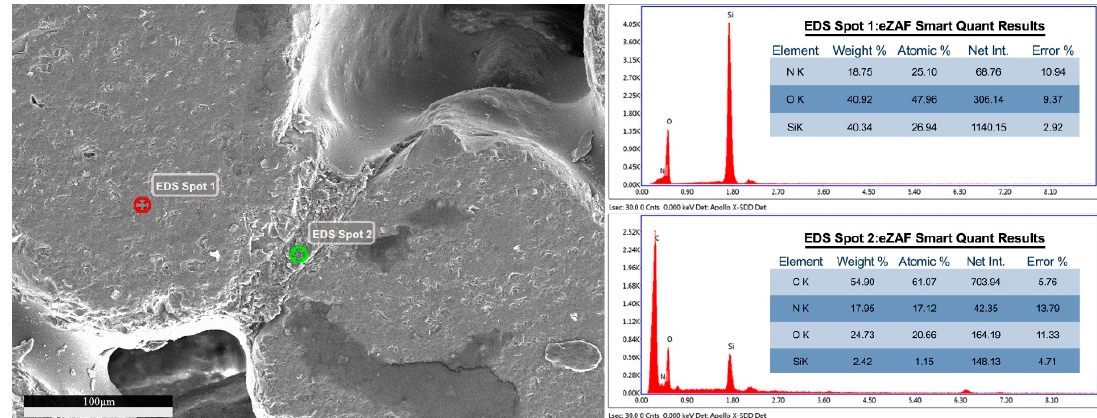
Figure 16. Energy-dispersive X-ray spectroscopy (EDS) analysis of the aggregate and the binder.